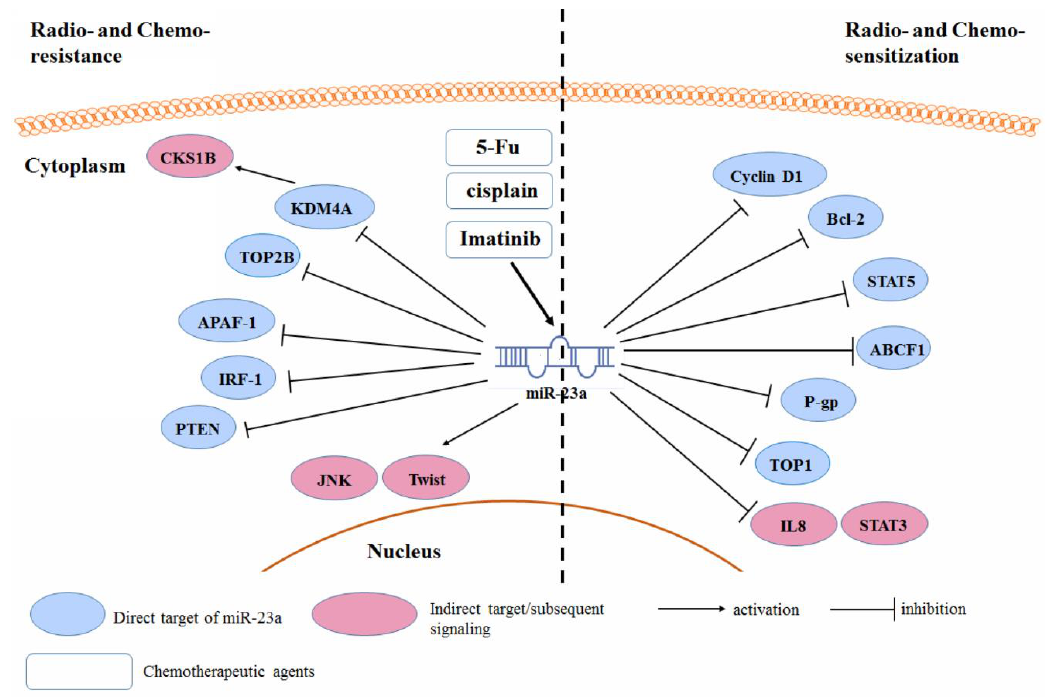
Figure 5. Regulation of the miR-23a on the sensitivity of cancer cells to the anti-cancer treatment.